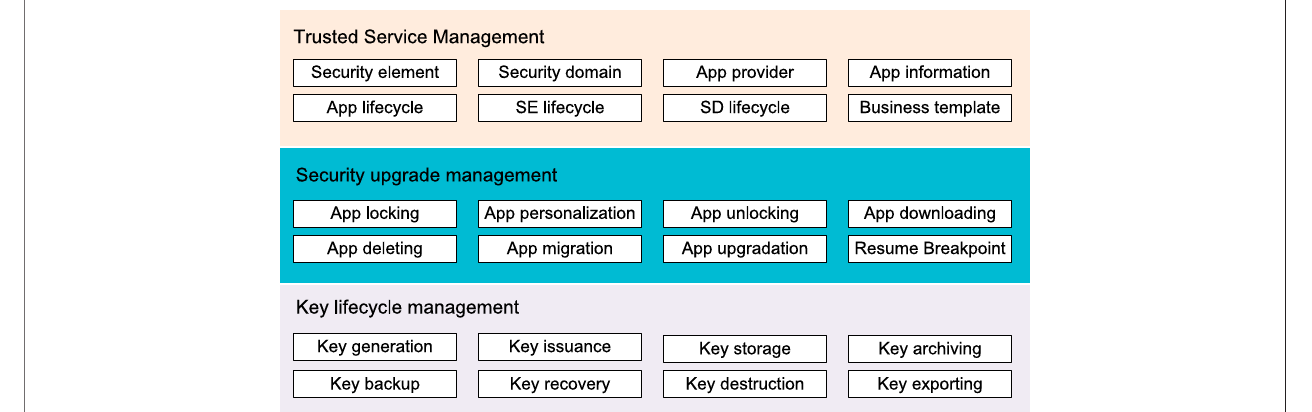
FIGURE 5 | Structure of a trusted service management.